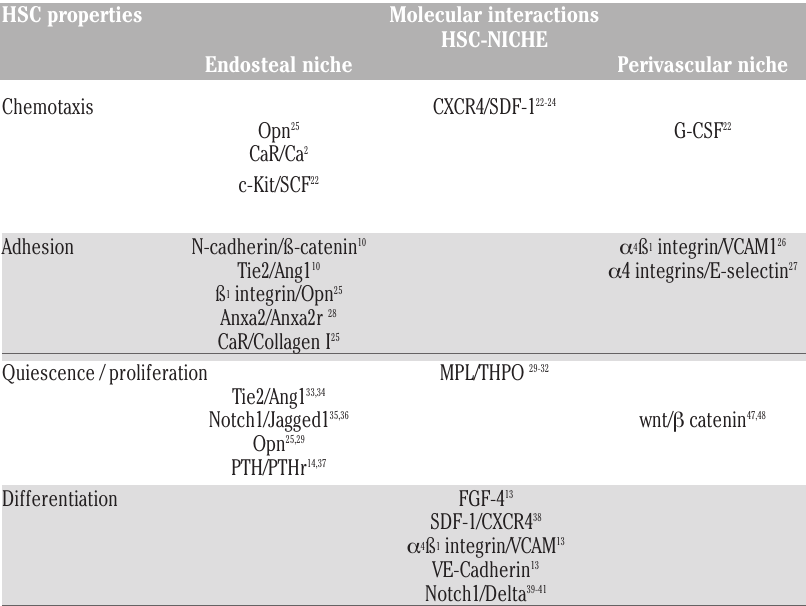
Table 1. HSC properties are regulated by molecular cues conveyed by the bone marrow endosteal and vascular niches. HSC properties Molecular interactions